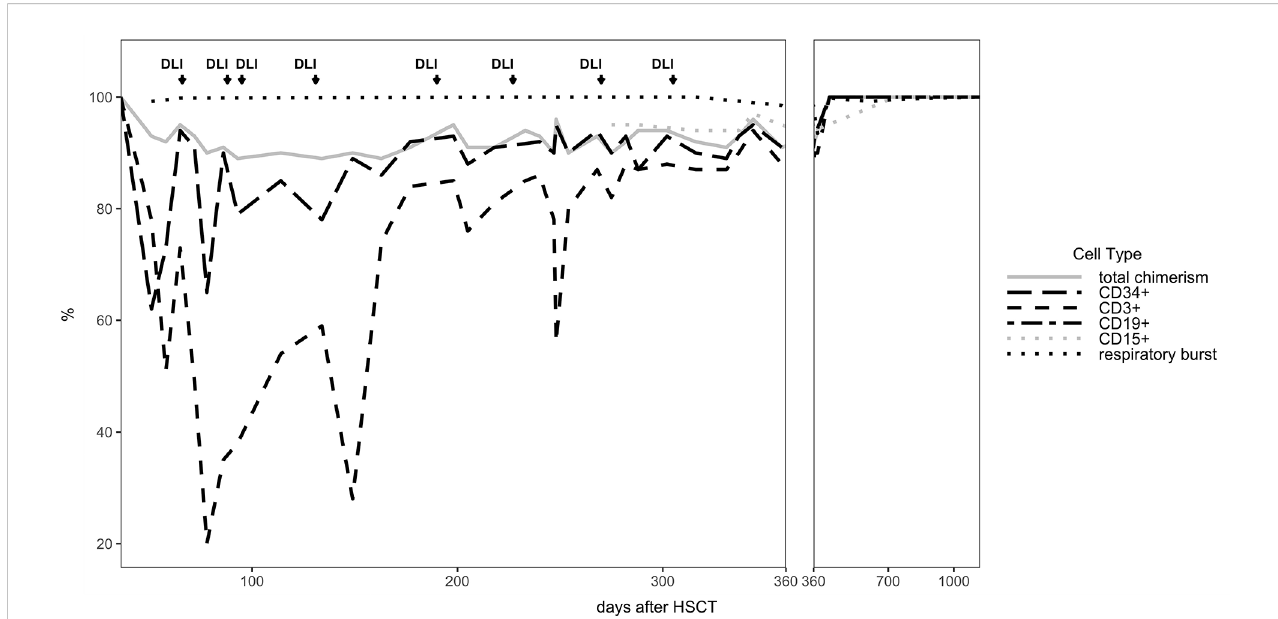
FIGURE 2 Donor Chimerism in peripheral blood for CD34 + , CD3 + , total cells (total chimerism) and respiratory burst in patient ’ s neutrophils measured by DHR test are shown for the entire follow up time of 3